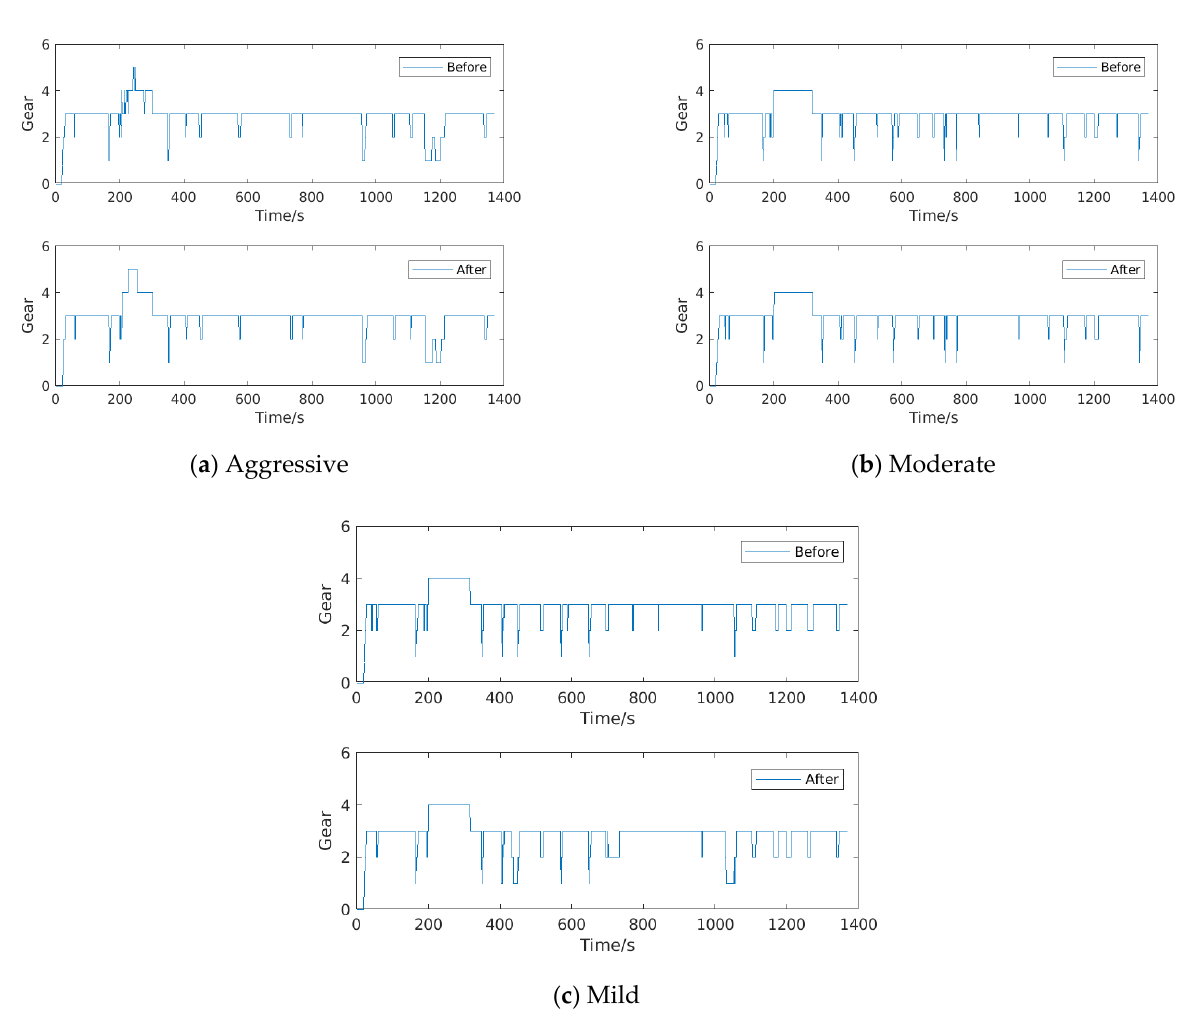
Figure 10. Gear indications of three drivers: Before and after calibrations. ( a ) Aggressive driver; ( b ) Moderate driver; ( c ) Mild driver.